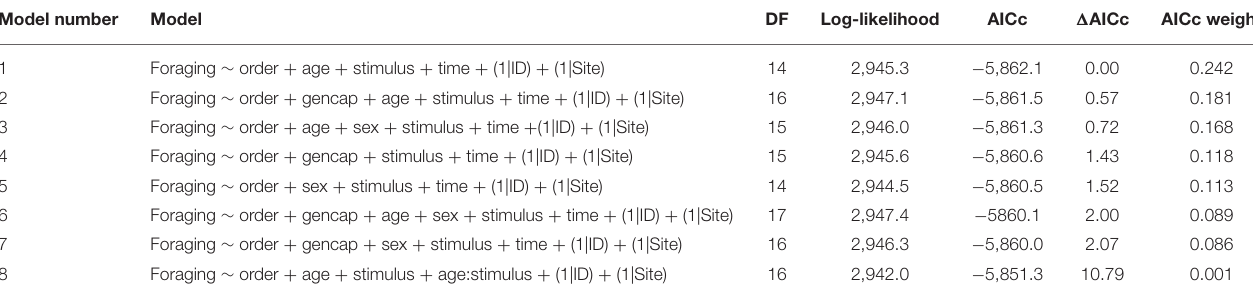
TABLE 2 | Candidate models for the proportion of time marmots allocated to foraging ranked by AICc weight, with degrees of freedom (DF), log-likelihoods, AICc values, 1 AICc values, and AICc weights. Model number